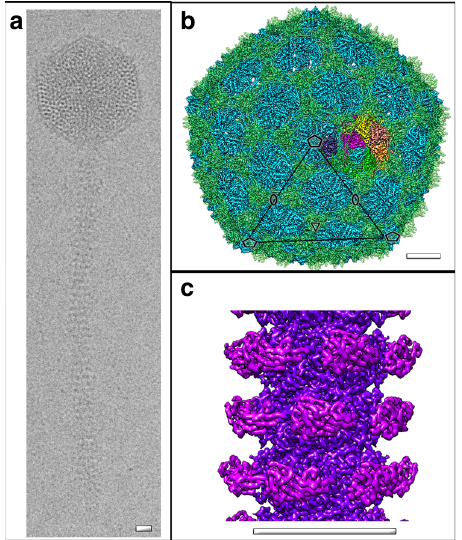
Fig. 1 Structural architecture of YSD1. a Vitri fi cation conditions were optimised to trap the fl exible Siphoviridae tail tubes as relatively straight segments. Representative cryo-EM image of a YSD1 virion ( fi ve imaging sessions). Cryo-EM reconstruction of the YSD1 head ( b ) and tail tube ( c ). Major capsid protein (YSD1_17) is shown in blue, auxiliary protein (YSD1_16) is shown in green and one icosahedral asymmetric unit is highlighted in colour (cf. Supplementary Fig. 2 for details). Icosahedral axes are indicated by ellipses, triangles and pentagons for twofold, threefold and fi vefold symmetry axes, respectively. Scale bars = 10